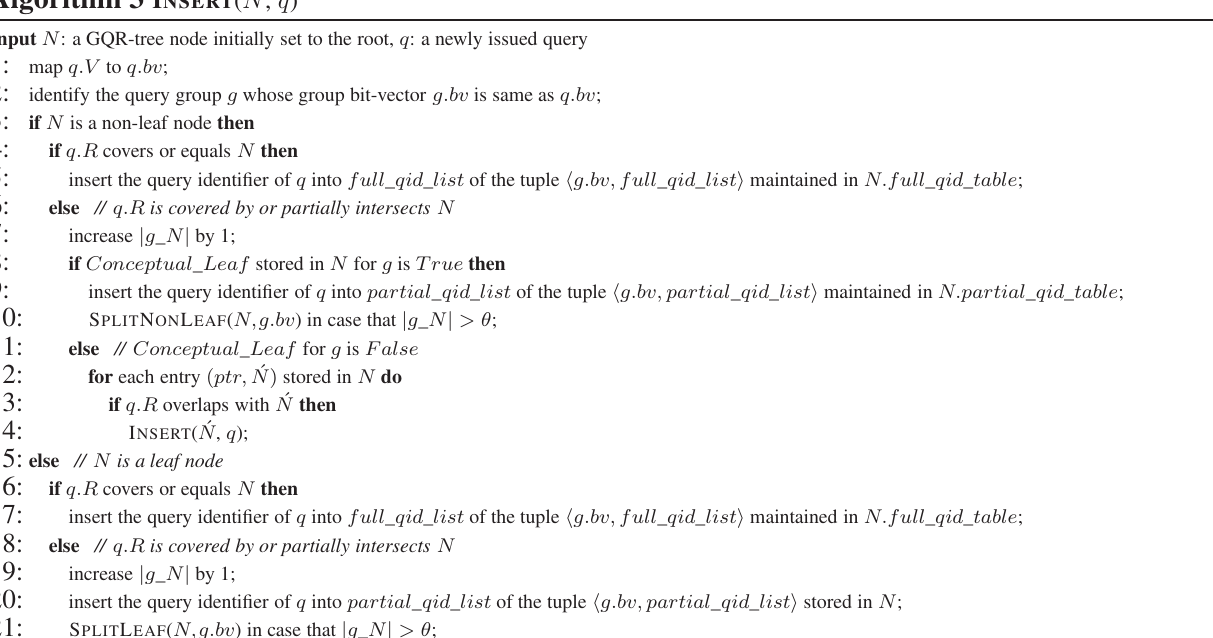
Algorithm 4 is the pseudocode of S PLIT N ON L EAF . Given a non-leaf node N and a group